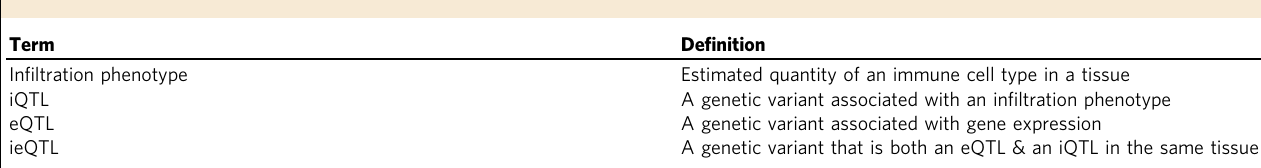
Table 1 Summary of important terms de fi ned in the